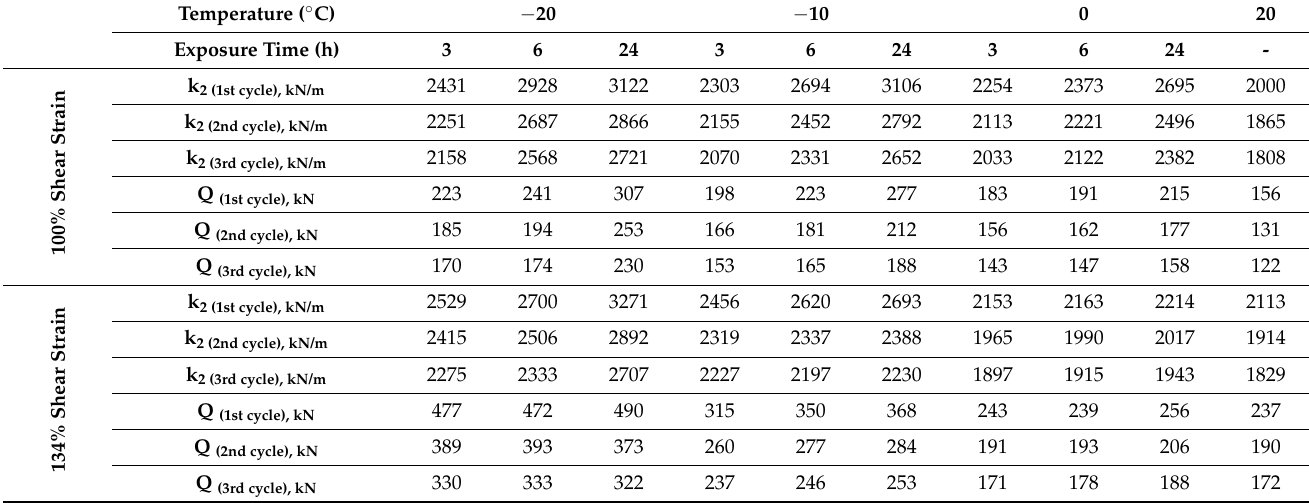
Table 3. Mechanical properties of LRB computed at the frequency of 0.5